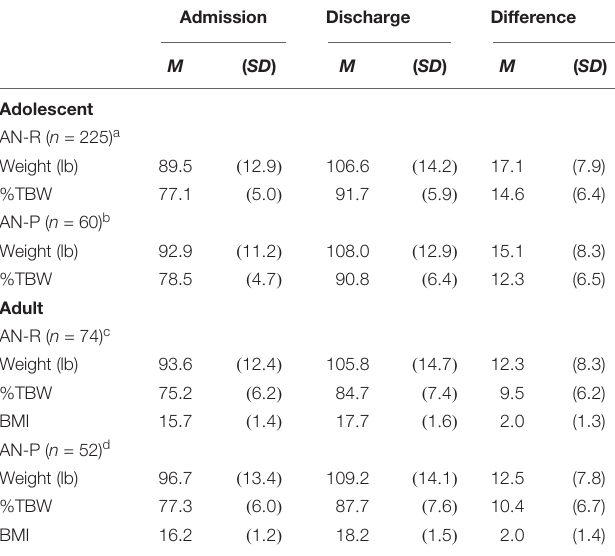
TABLE 4 | Change in weight of adolescent and adult patients with active AN on